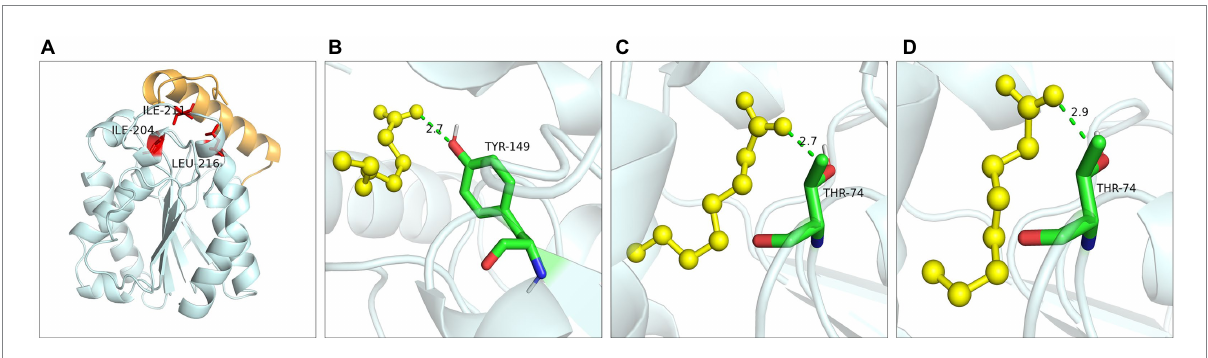
FIGURE 9 Catalytic function analysis of Ile204, Ile211 and Leu216. (A) Spatial position of Ile204, Ile211 and Leu216. Molecular docking of (B) L216T, (C) L216K, (D) L216D to octanoic acid.